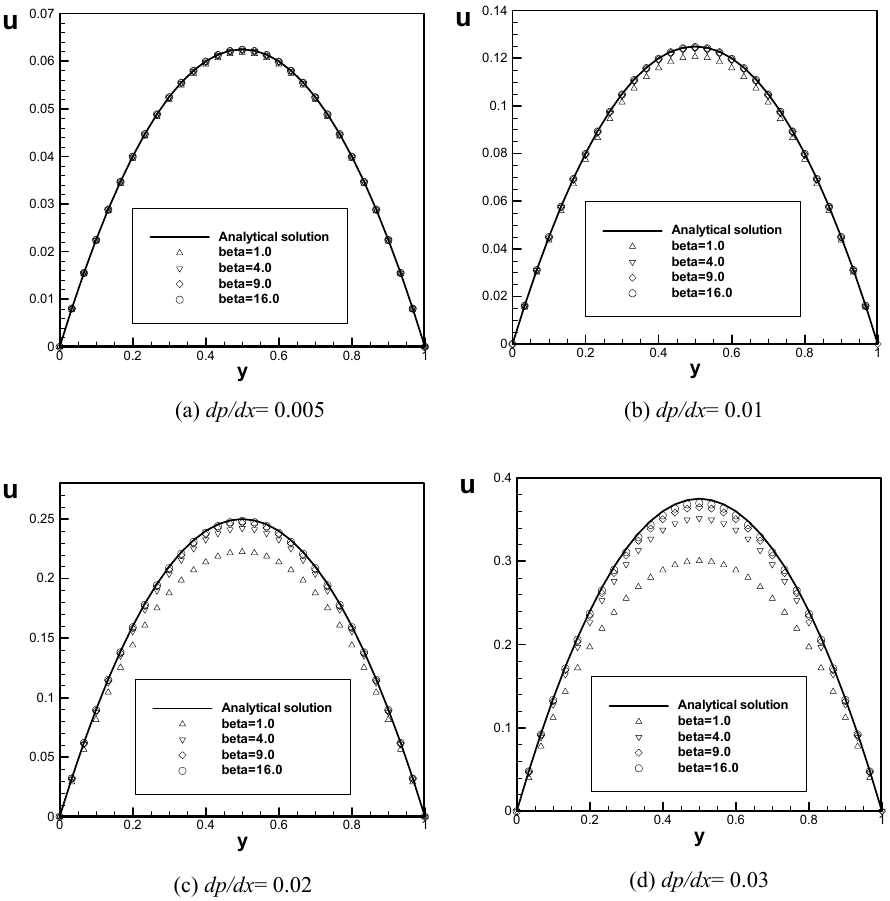
Fig.2 The profile of dimensionless horizontal velocity in Poiseuille flow at the middle of channel for different